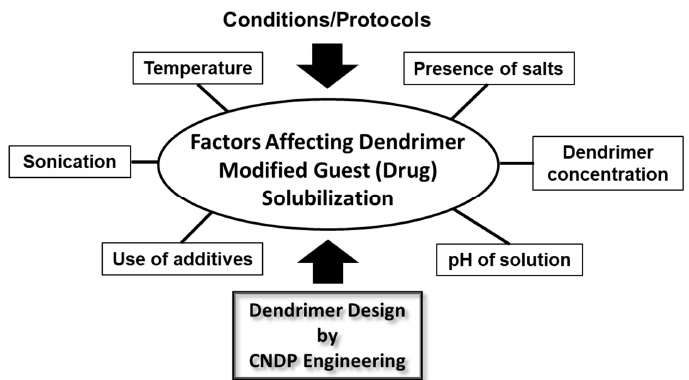
Figure 18. Factors affecting dendrimer modified guest (drug) solubilization conditions/protocols and dendrimer structural design by CNDP engineering.